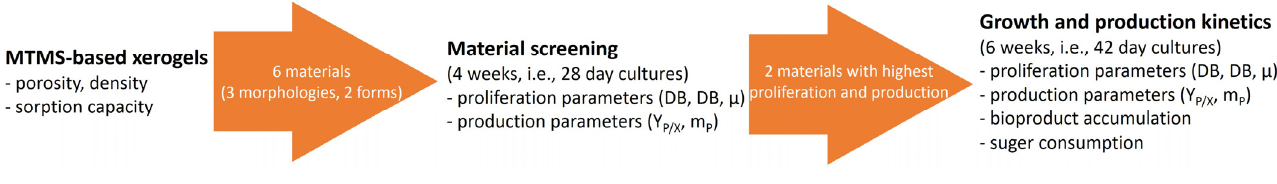
Figure 1. Schematic presentation of investigation